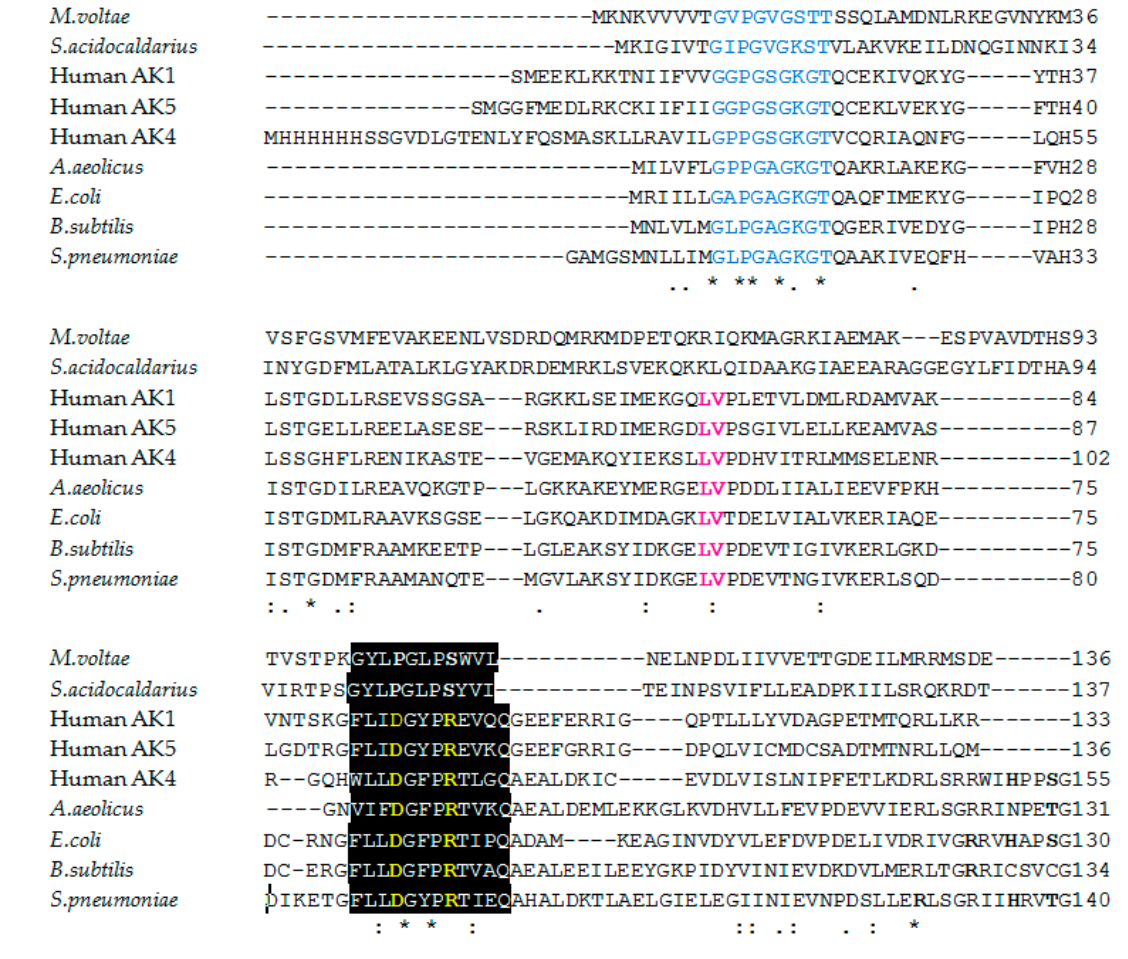
Figure 2. Multiple sequence alignment of the AKs’ sequences. Marked in blue are the residues belonging to the Walker A motif—phosphate-binding loop or P-loop; in the black background was selected the consensus sequence [LIVMFYWCA]-LIVMFYW] (2) -D-G-[FYI]-P-R-X (3) -[NQ] and in yellow were selected the residues strictly conserved in the adenylate kinase family; with pink were selected the Lys and Val residues—well conserved in AKs. Multiple sequence alignment was performed by the Clustal Omega program (https://www.ebi.ac.uk/Tools/msa/clustalo). * (asterisk) indicates positions which have a single, fully conserved amino acid residue; : (colon) indicates conservation between groups of strongly similar properties as following—roughly equivalent to scoring >0.5 in the Gonnet PAM 250 matrix: STA, NEQK, NHQK, NDEQ, QHRK, MILV, MILF, HY, FYW; . (period) indicates conservation between groups of weakly similar properties as following—roughly equivalent to scoring =<0.5 and >0 in the Gonnet PAM 250 matrix: CSA, ATV, SAG, STNK, STPA, SGND, SNDEQK, NDEQHK, NEQHRK, FVLIM, HFY